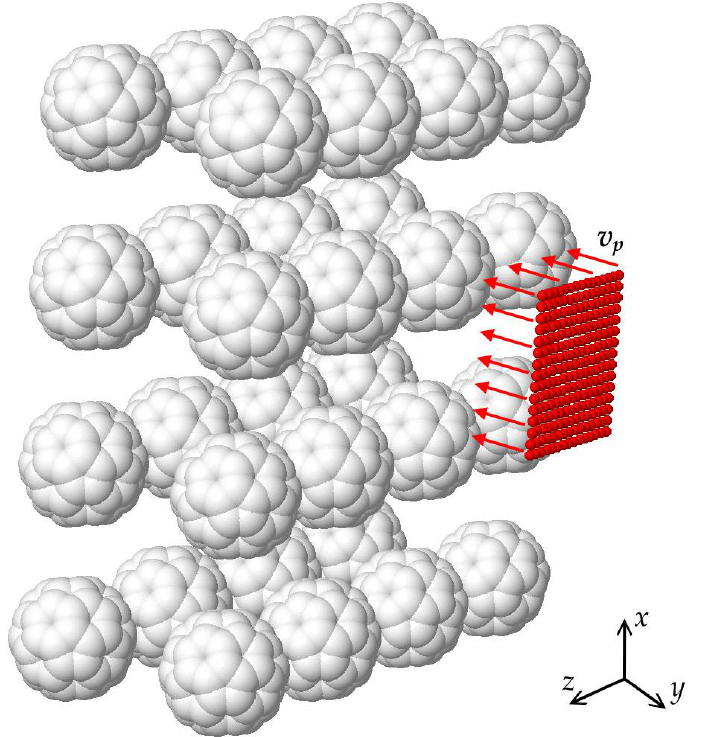
Figure 1. Scheme of the interaction of incoming particles (red color) with a group of rotating C 60 molecules (grey color).